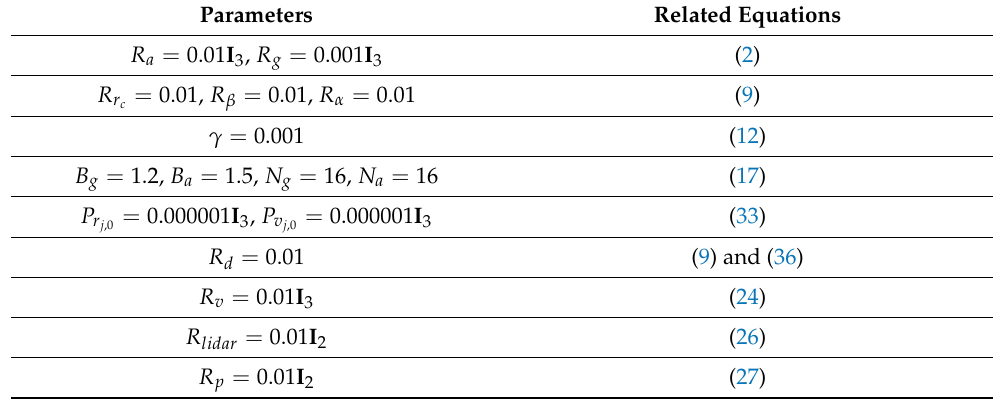
Table 2. Parameters used in this paper.